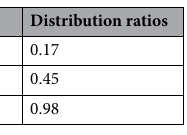
Table 5. Distribution ratios of stripping of arsenic ions using various types of strippant solutions.